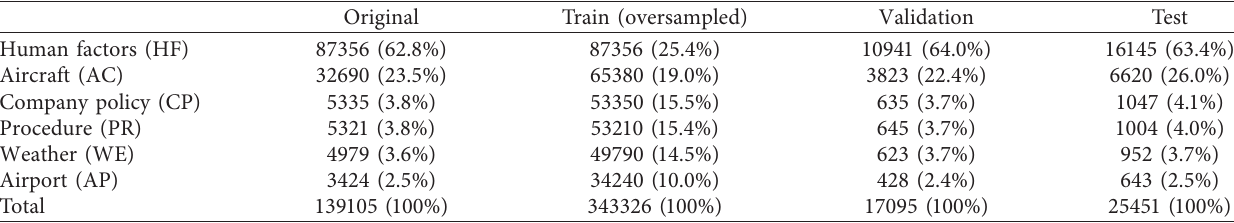
Table 6: The summary of the incident reports and their label distribution in the training set before and after data oversampling, as well as validation and test